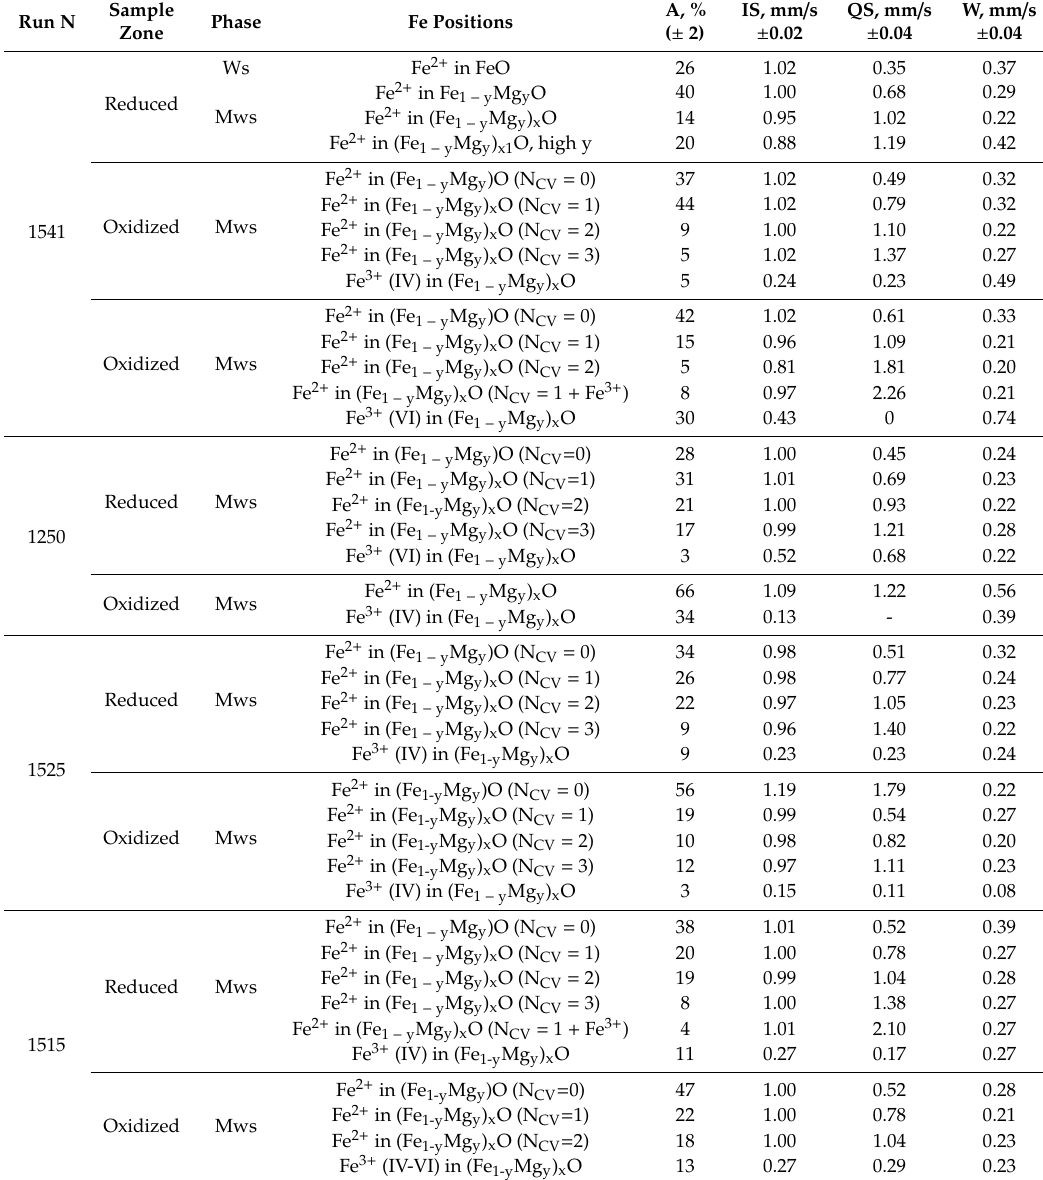
Table 3. Results of the Mössbauer spectroscopy of magnesiowüstite and wüstite formed in the carbonate-metal